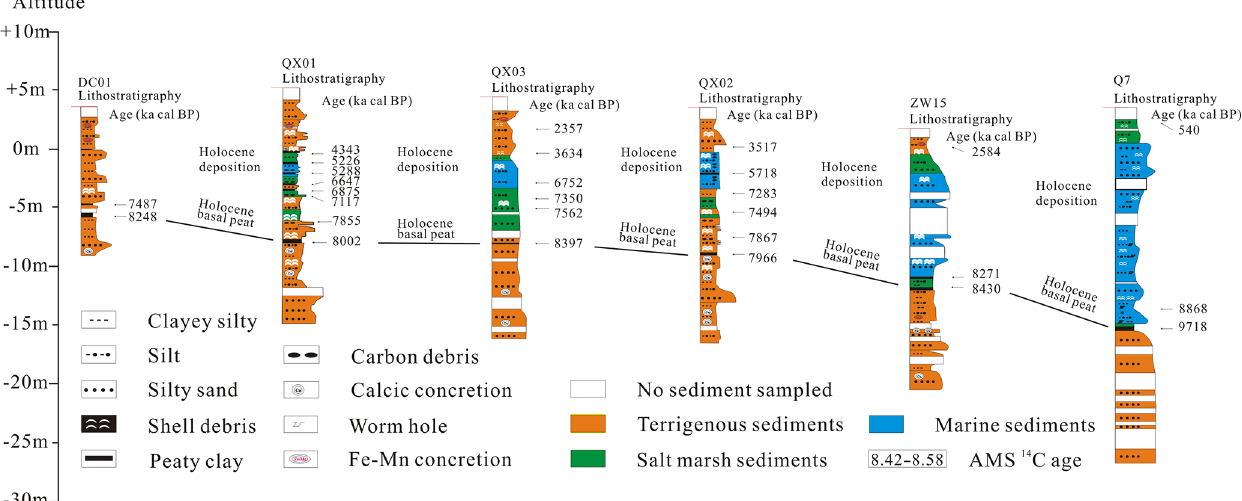
Figure 3. The lithostratigraphy of transect A, with details of dated sedimentary horizons.